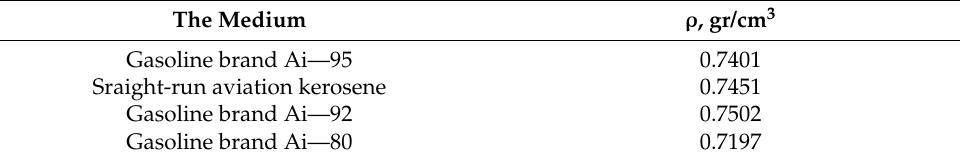
Table 3. The values of density of various media at T = 297.9